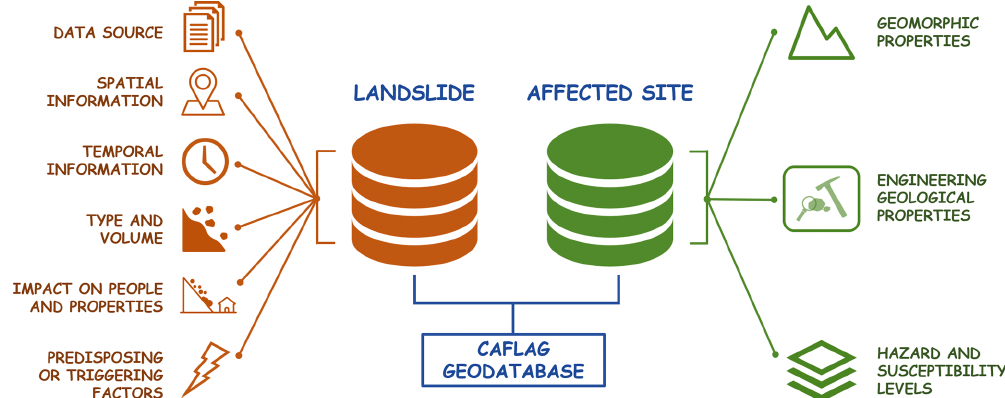
Figure 2. Overview of the information provided within the CAFLAG geodatabase.